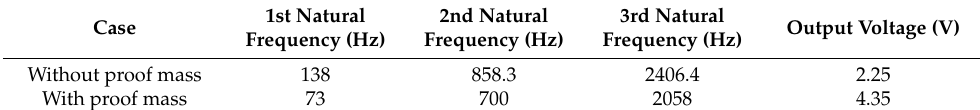
Table 4. The natural frequencies for the rectangular beam with and without a proof mass.